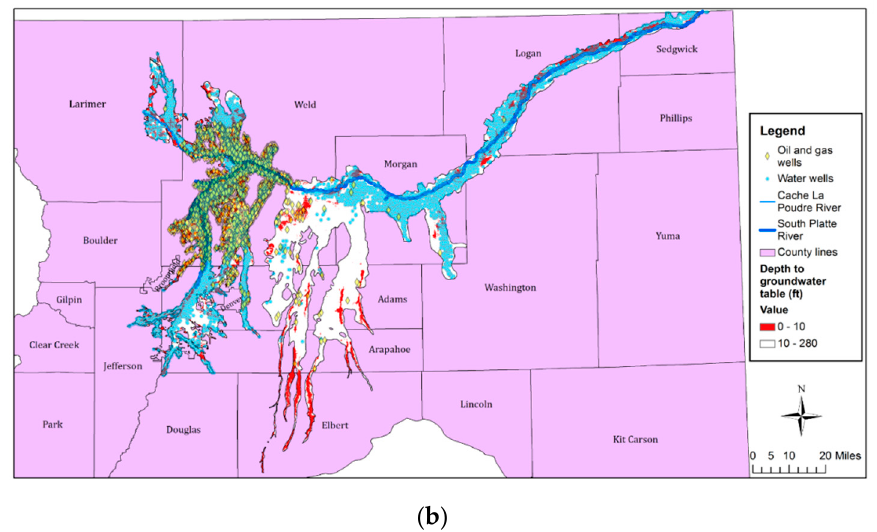
Figure 1. Map of the South Platte Alluvial Aquifer in the Front Range of Colorado with ( a ) depth to groundwater [11,12] shown in color; ( b ) showing overlap between presence of shallow groundwater tables, oil and gas activity [13], and water wells [14]. Counties of Colorado are labeled and shown in light purple [15]. Light blue circles represent water wells drilled into the South Platte Alluvium.